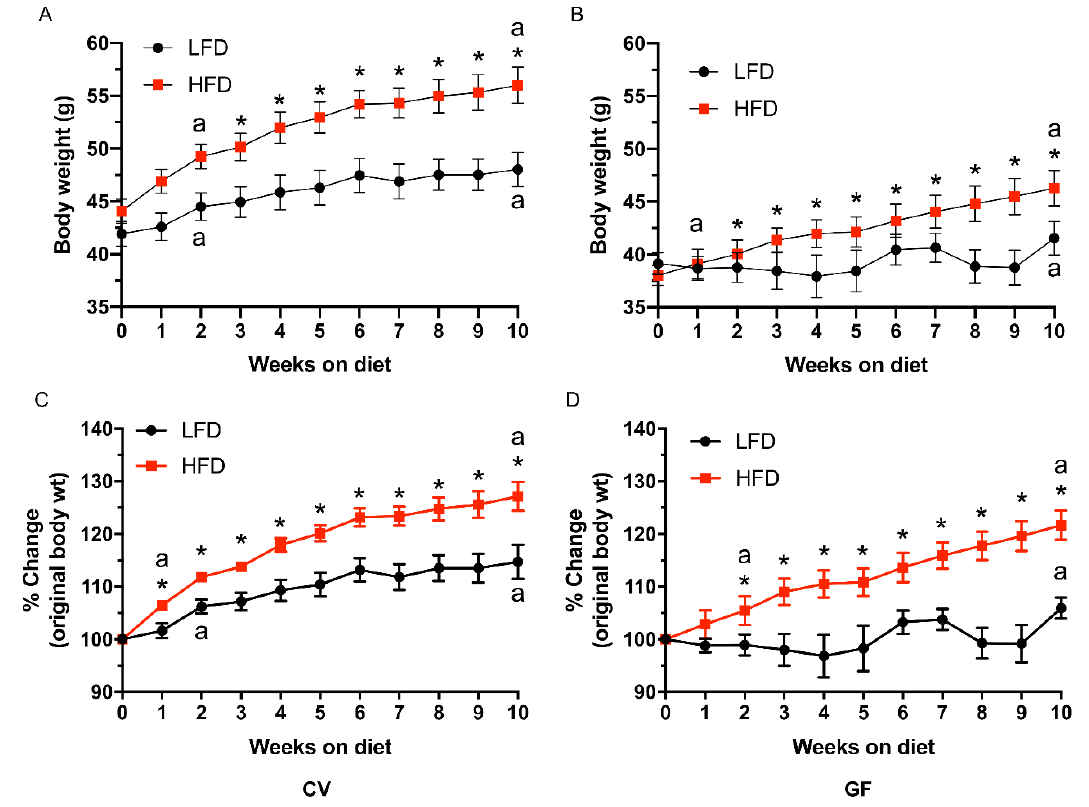
Figure 1. The HFD increases body weight in both CV ( n = 10; panels A , C ) and GF ( n = 11; panels B , D ) male Tac:SW mice. Absolute body weight changes are shown in grams (panels A , B ), or as percent change from original body weight (panels C , D ). Values are expressed as the mean ± SEM. An “a” denotes statistically significant increases in body weight, compared to baseline body weight at week 0, and are only shown at the start and end of statistical significance. An asterisk denotes statistically significant diet difference within CV and within GF mice, when comparing the effects of the HFD on weight gain to the LFD, at p ≤ . 0.05. Abbreviations: CV, conventional; GF, germ-free; HFD, high fat diet; LFD, low fat diet; Tac:SW; Taconic Swiss Webster. Table 3. Effect of the low- and high-fat diets on body and tissue weight, feed consumption, and feed conversion in conventional and germ-free male Tac:SW mice. Conventional p -Values